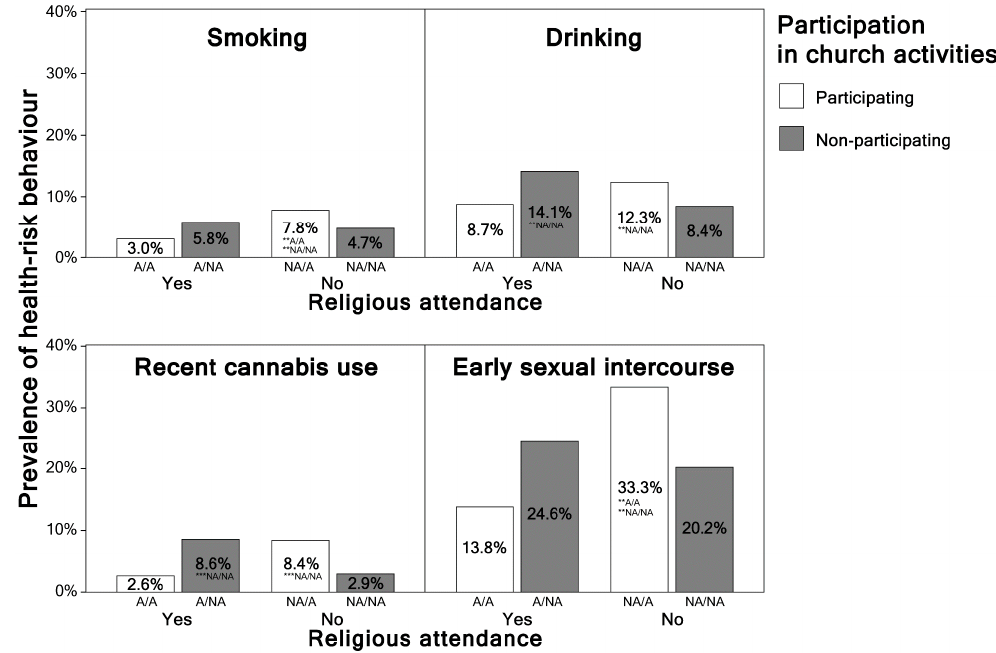
Figure 1. Prevalence of adolescent smoking, drinking, recent cannabis use, and early sexual intercourse in groups with di ff erent combinations of religious attendance and participation in church activities (Czech Republic, 2018). (Notes: ** p < 0.01, *** p < 0.001; A / A = attending / church activities; A / NA = attending / no church activities; NA / A = non-attending / church activities; NA / NA = non-attending / no church activities).